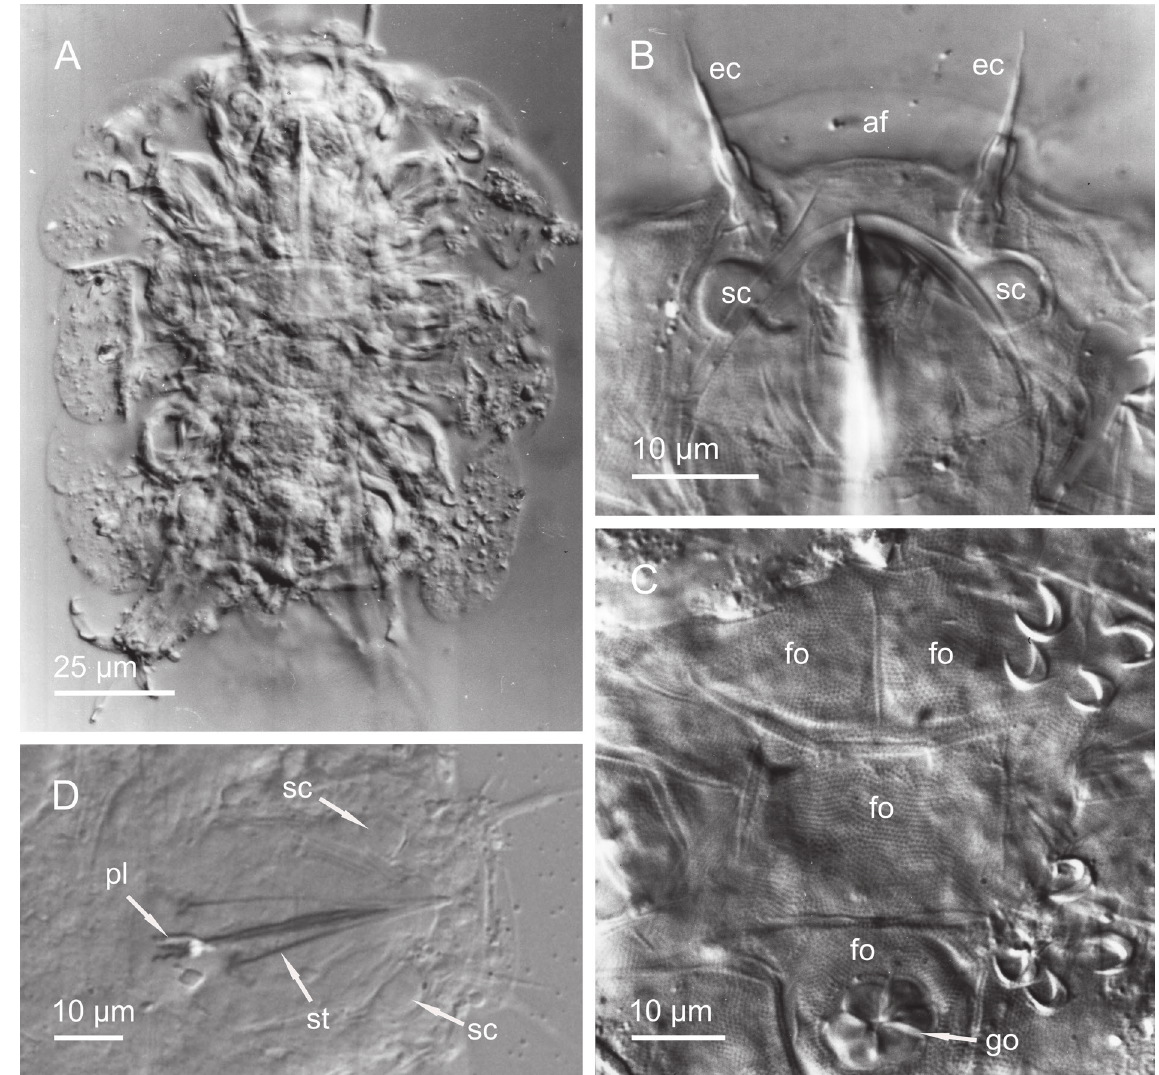
Fig. 16. DIC-micrographs of Higginsarctus laurae gen. et sp. nov. A . Paratype, ♀ (NHMD-293907). Overview. B–D . Paratype, ♀ (NHMD-293908). B . Close up on the head, ventral view showing